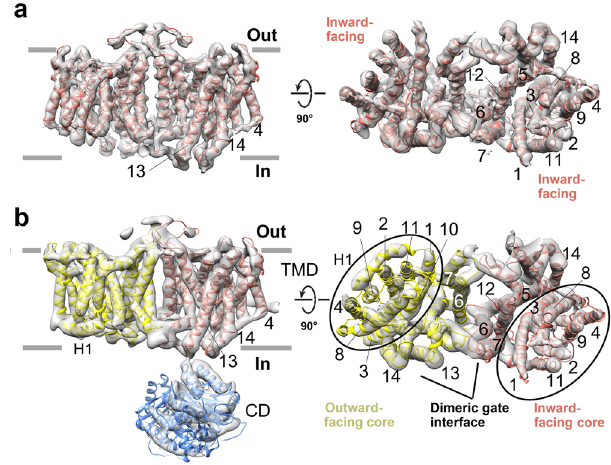
Fig. 2 Coexistence of IF and OF monomers in AE1 dimer. a Bovine AE1 dimer with both monomers in the IF state. b Bovine AE1 dimer with monomers in OF (yellow) and IF (salmon) conformations. The CD and OF and IF cores, as well as the dimeric gate interface are also shown.